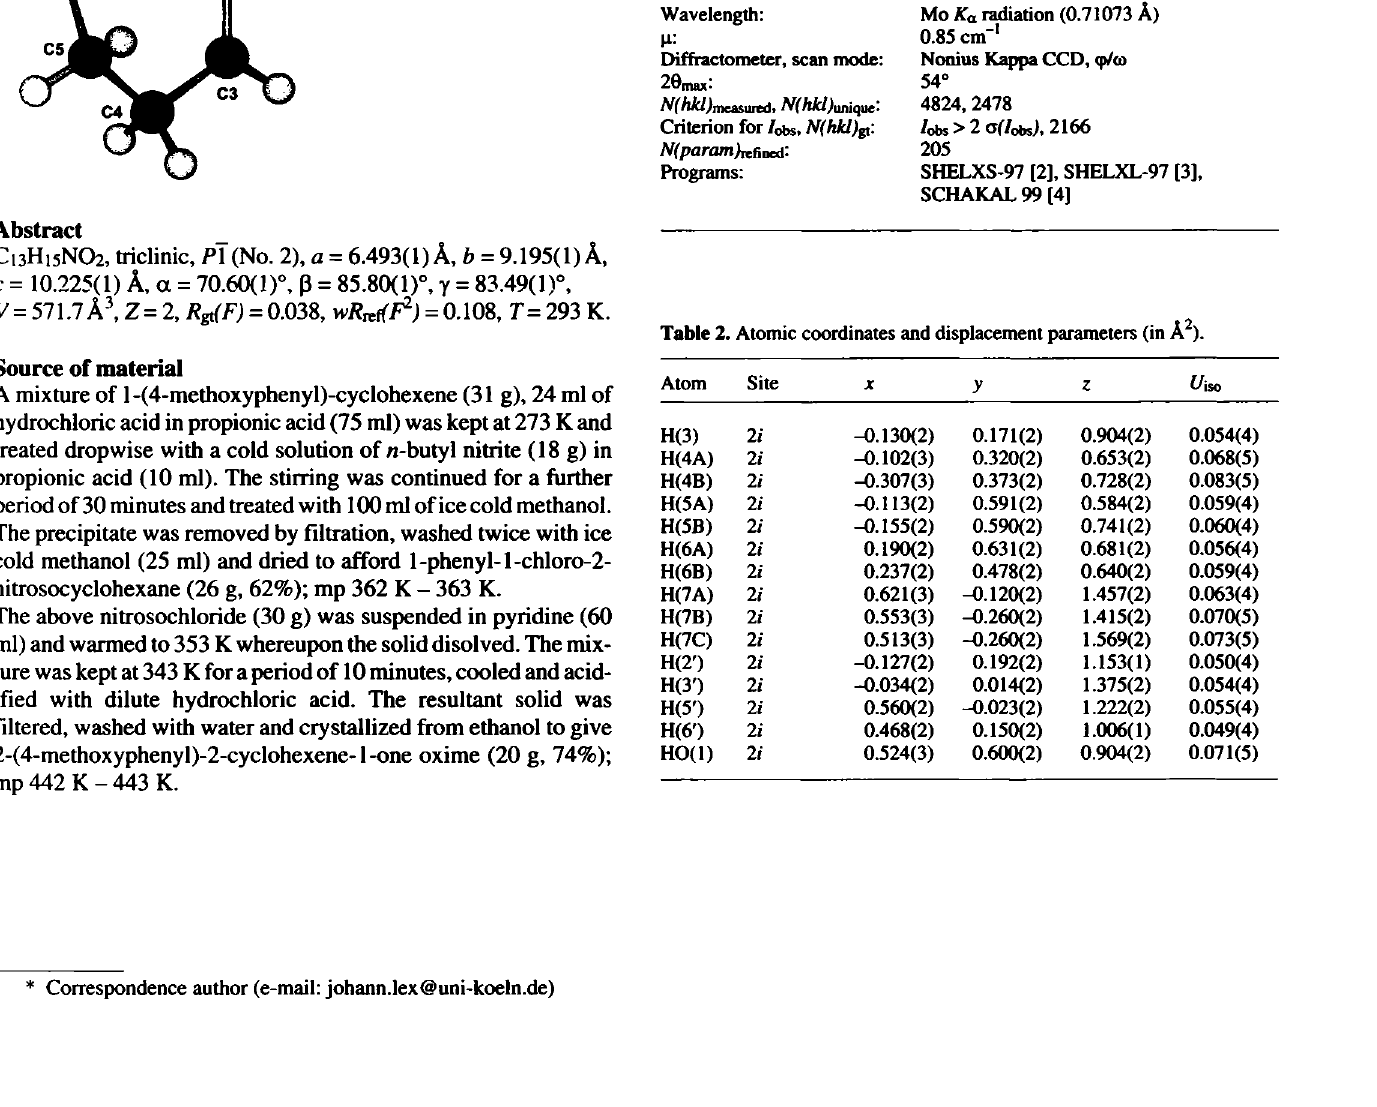
Table 1. Data collection and handling.